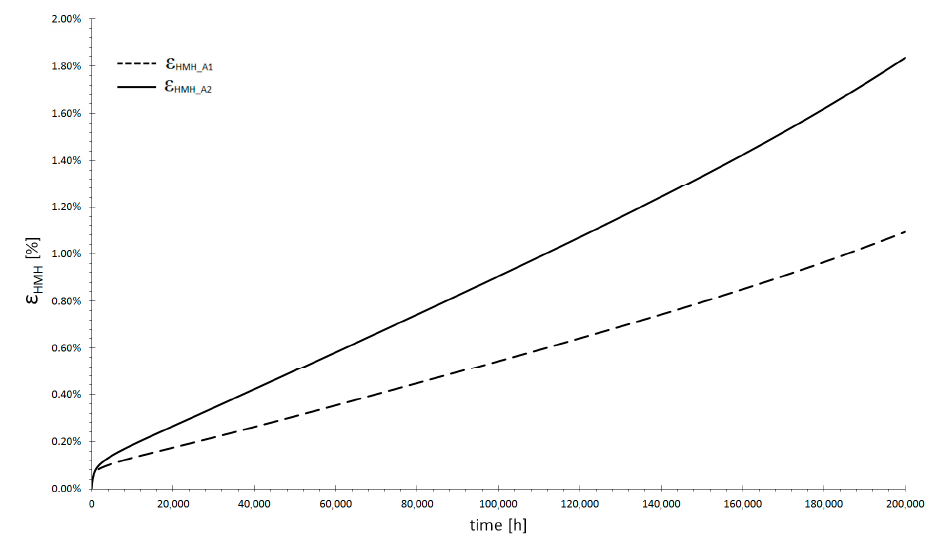
Figure 11. Creep curve for points A1 and A2.